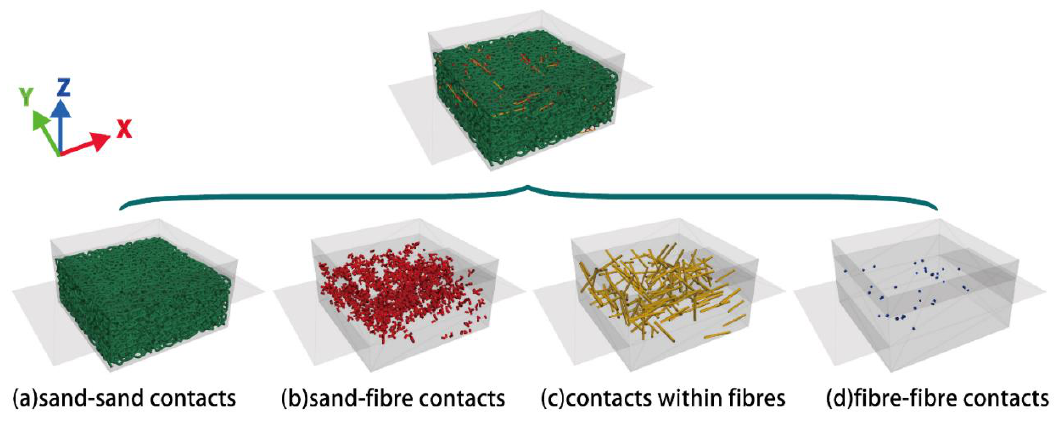
Figure 3. Contact types in FRS model.